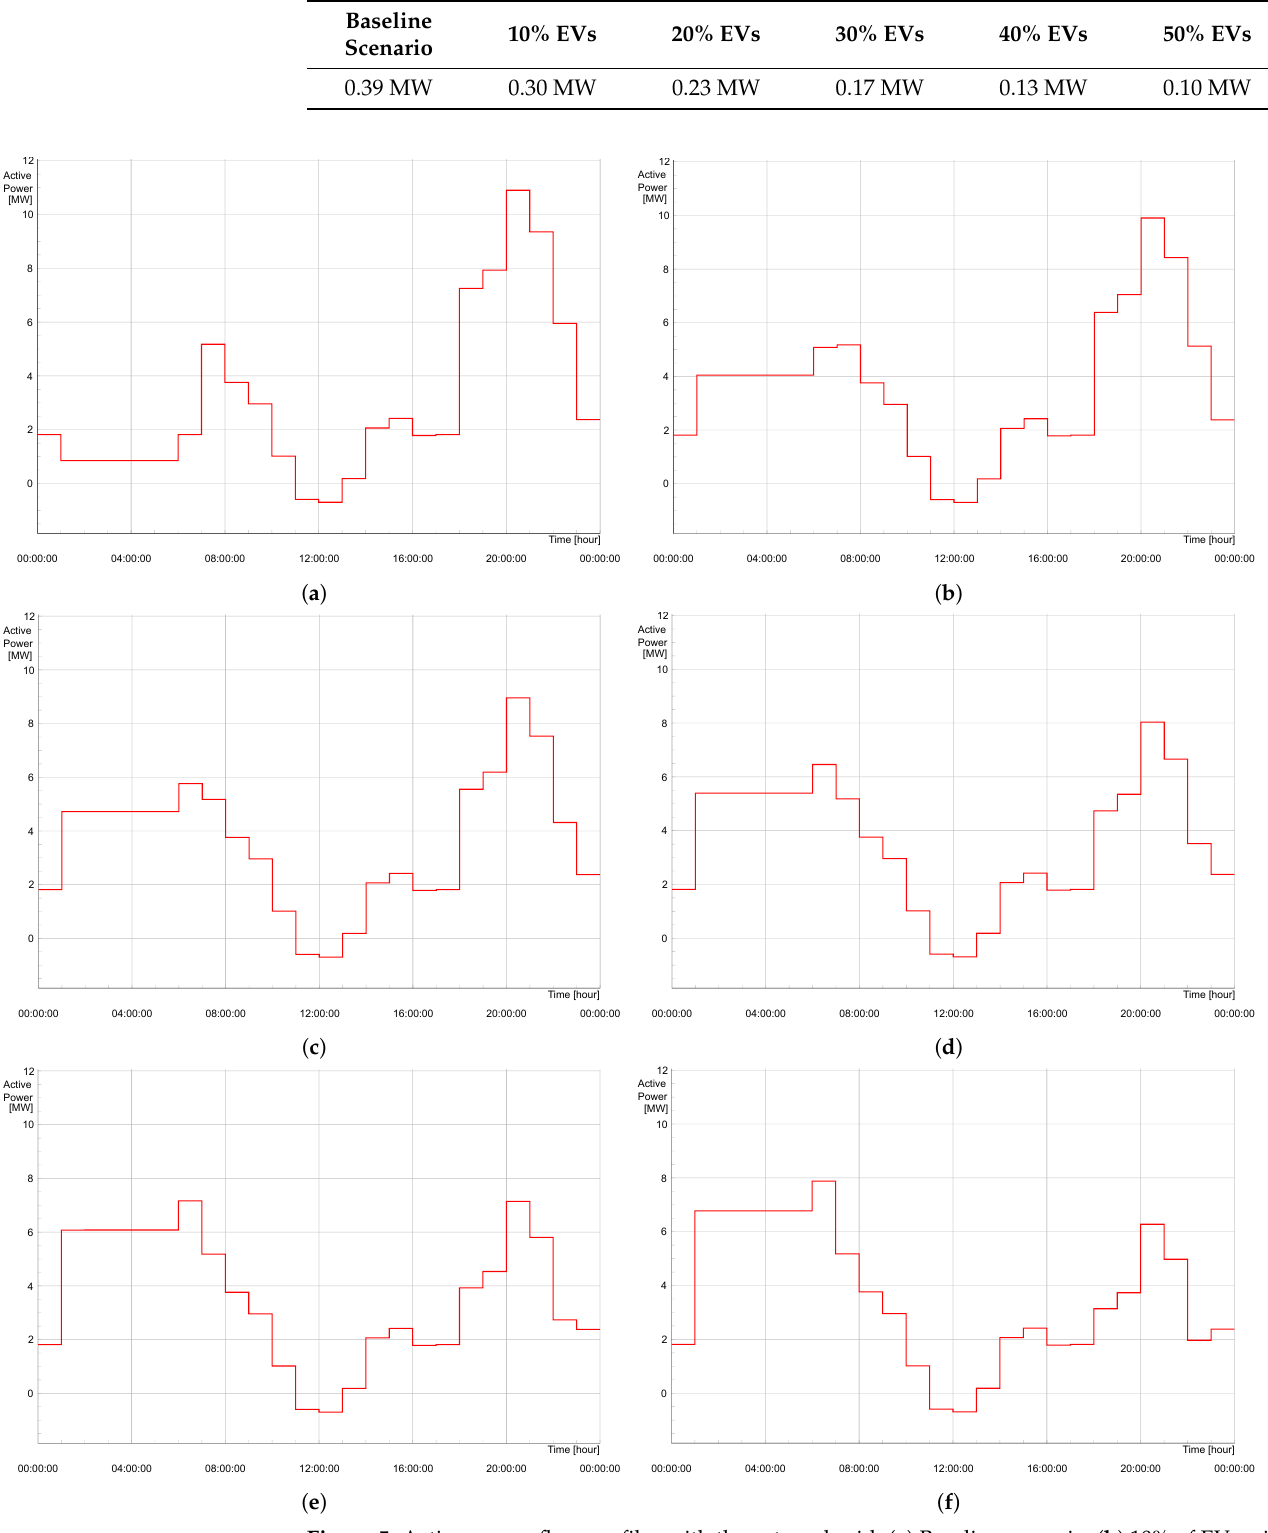
Figure 5. Active power flow profiles with the external grid: ( a ) Baseline scenario, ( b ) 10% of EVs with V2G , ( c ) 20% of EVs with V2G , ( d ) 30% of EVs with V2G , ( e ) 40% of EVs with V2G , ( f ) 50% of EVs with V2G